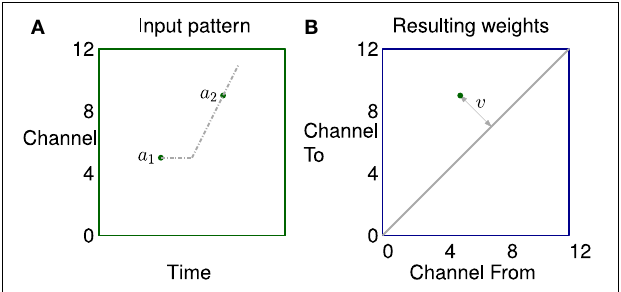
FIGURE 6 | The learning of a simple correlation in the network. (A) Activity in a channel followed by activity in another channel some time later, represented by the dots a 1 and a 2 which are in channels 5 and 9 in this example. The propagation of activity through the lateral connections has a fixed offset and a velocity each represented by broken gray lines in (A) . (B) Plastic synapses connecting the neuron excited by a 1 to the neuron excited by a 2 are potentiated if they are on the broken gray line representing the propagation of activity. These synapses are at position ( 5 , 9 ) on the weight matrix shown by a dot. The distance from the diagonal v is proportional to the apparent sweep velocity from a 1 to a 2